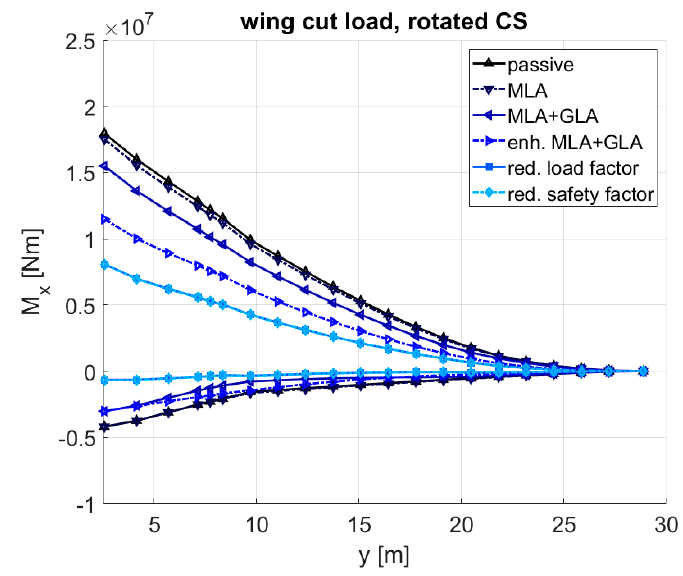
Figure 45. Overview of gust bending moment envelopes.